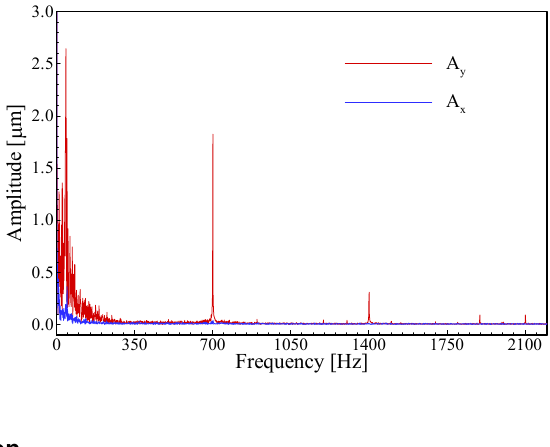
Figure 16. Frequency response of an antennal hair of a fire ant to a vibration signal of 700